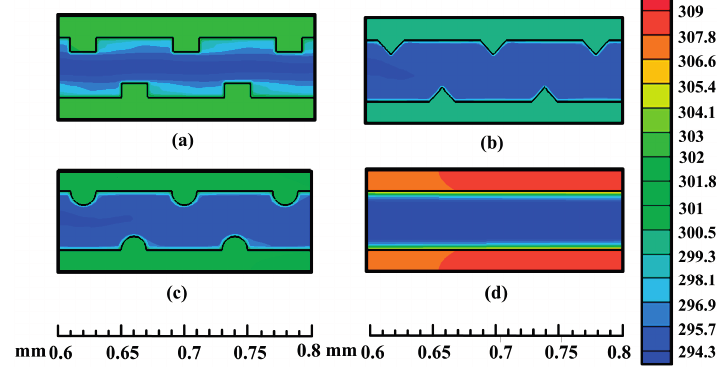
( a ) rectangular ribbed microchannel, ( b ) triangular ribbed microchannel, ( c ) semicircular ribbed microchannel and ( d ) smooth microchannel at Re = 1000.